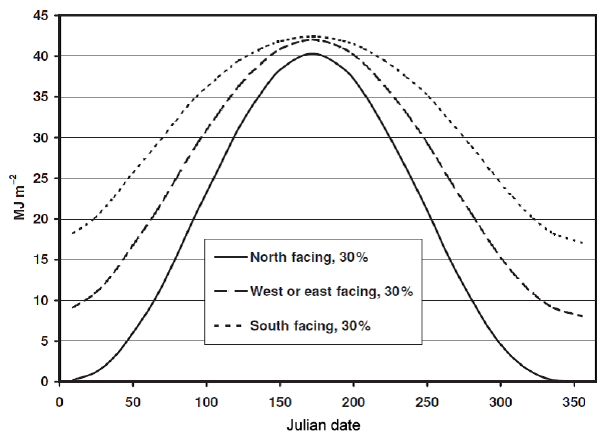
Figure 1. Extraterrestrial solar irradiance at 50 ◦ N for north-, south- and east-/west-facing 30% slopes. Note the small differences as summer solstice is approached (after Gray and Male,